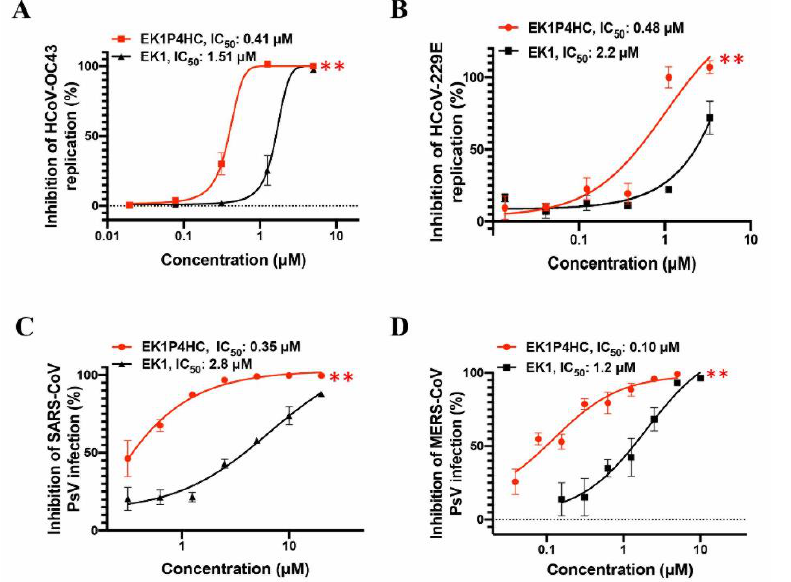
Figure 5. Broad HCoV inhibitory activity of EK1P4HC. ( A ) Inhibitory activity of EK1P4HC against HCoV-OC43 replication. ( B ) Inhibitory activity of EK1P4HC against HCoV-229E replication. ( C ) Inhibitory activity of EK1P4HC against SARS-CoV PsV infection. ( D ) Inhibitory activity of EK1P4HC against MERS-CoV PsV infection. Each peptide was tested in triplicate, and experiments were repeated twice. Statistical differences were analyzed at the concentration of 1.25 μM of peptides, **, p < 0.01.